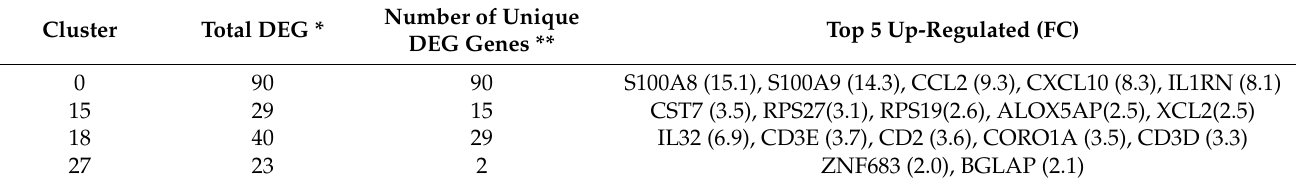
Table 7. Up-regulated DEGs in clusters identified as M1 macrophages.